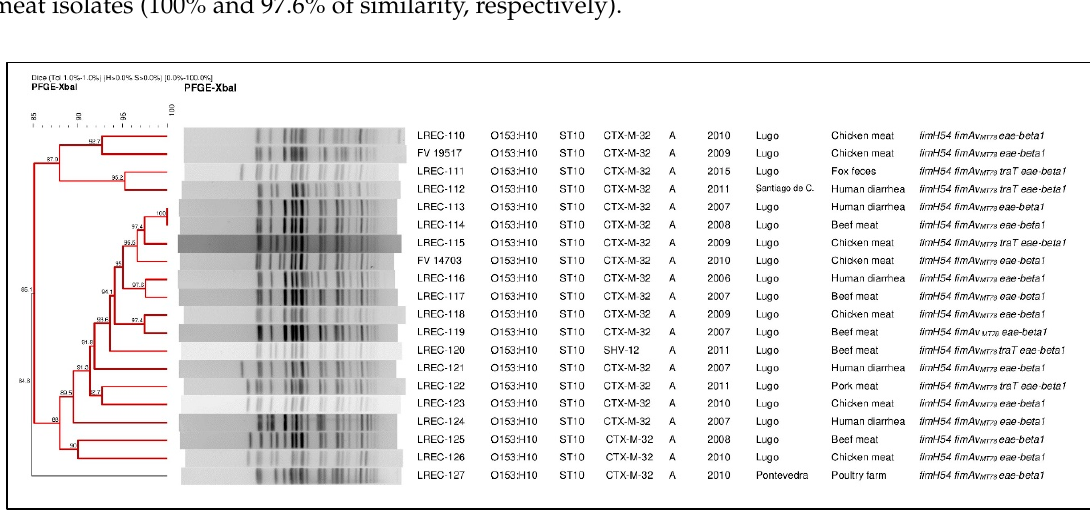
Figure 1. Pulsed field gel electrophoresis (PFGE) of XbaI -digested DNA from 20 ESBL-producing aEPEC isolates of the clonal group O153:H10-A-ST10 (one autodigested). On the right of the dendrogram: Isolate designation, O:H serotype, ST, ESBL type, phylogroup, year of isolation, geographic origin, source and virulence-gene profile.